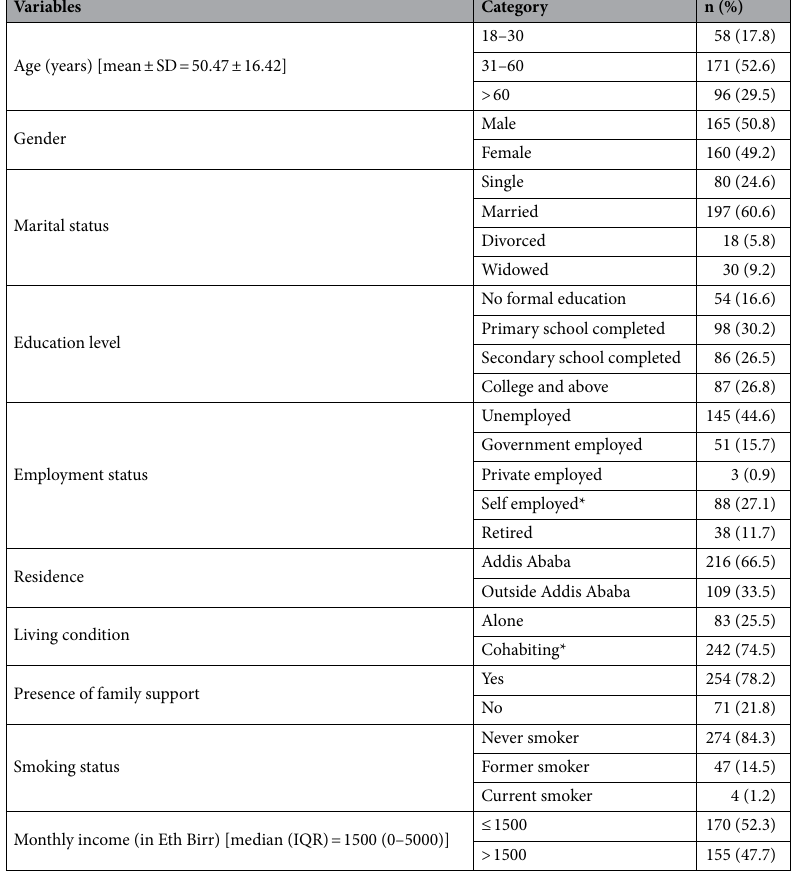
Table 1. Sociodemographic characteristics of patients with heart failure attending cardiac clinic of Tikur Anbessa Specialized Hospital, Addis Ababa, Ethiopia, August 01–September 30, 2021 (n = 325). Cohabiting*: living with a marriage partner, child, or another partner like family and/or friends, Self-employed*: farmer, daily laborer, merchant, driver, BMI body mass index, Eth Ethiopian, IQR inter quartile